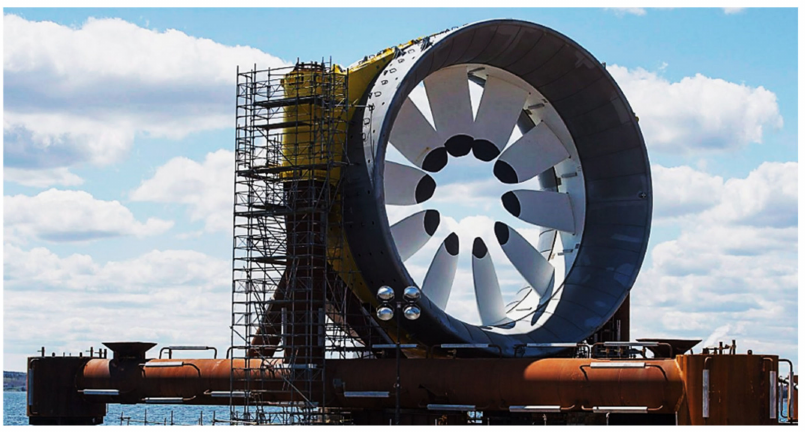
Figure 2. The 2 MW-rated OpenHydro ducted turbine. Adapted from [8], The Canadian Press/Andrew Vaughan,